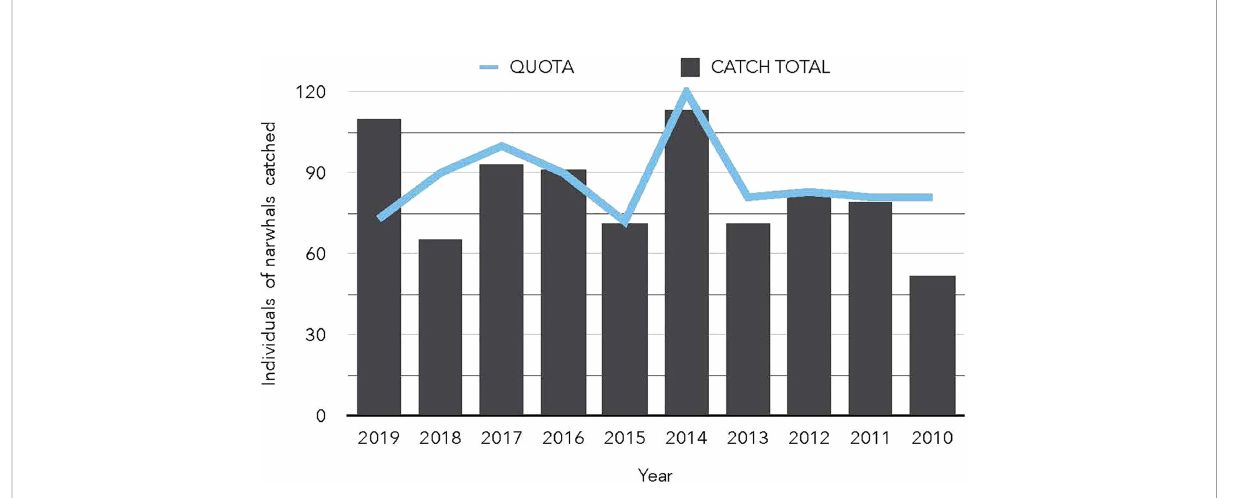
FIGURE 8 Total catches of narwhals in Melville Bay by year and its respective quota. Source: Own elaboration, data amended from Catch database — NAMMCO,